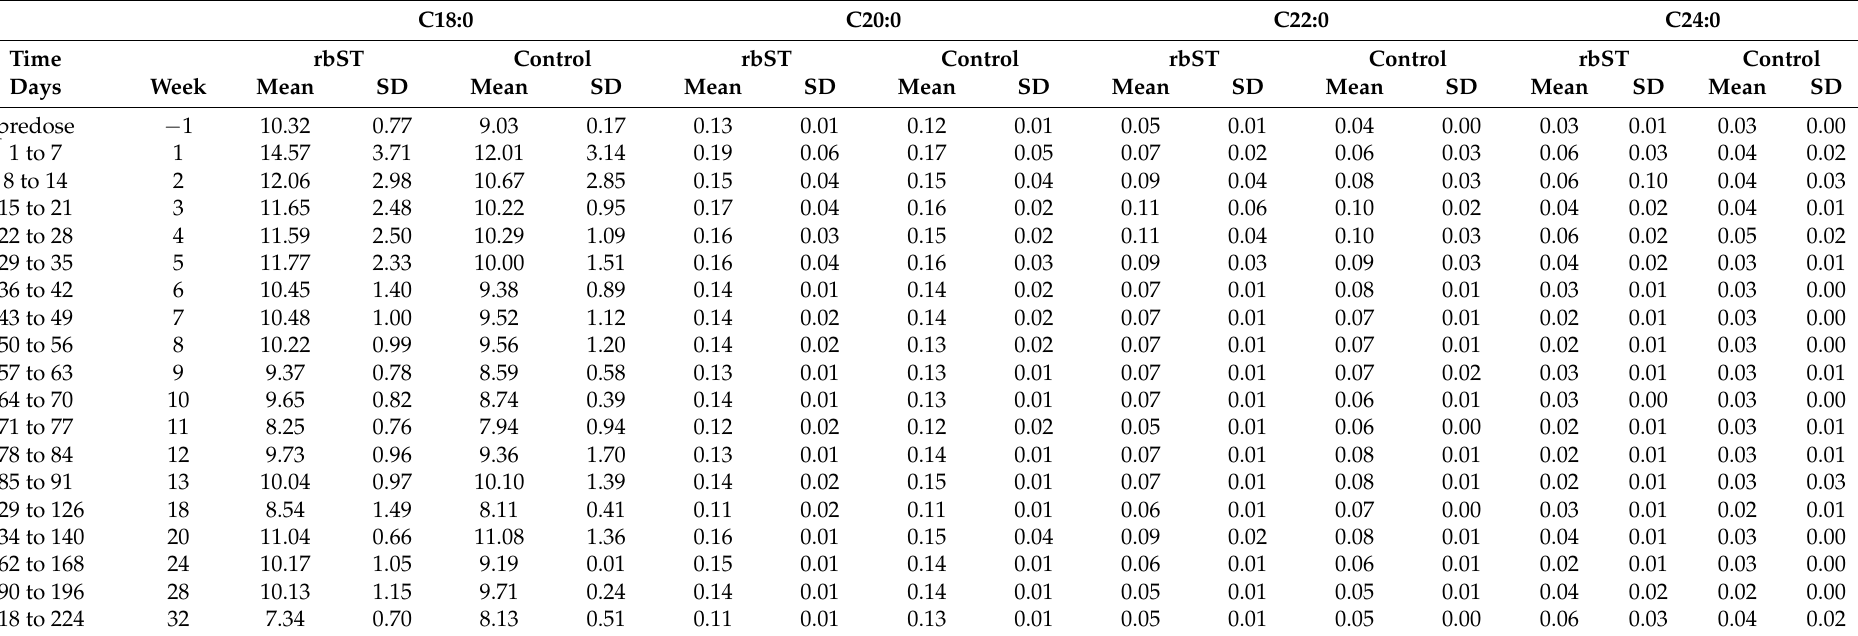
Table 3. Long-chain C18:0 and very-long chain ( ≥ 22) saturated fatty acids in milk (% w / w of total fatty acids) obtained from cows treated with recombinant bovine somatotropin (rbST) ( n = 6) and from control animals ( n = 3) at different time points selected over the course of 37 weeks (8 injections of Lactotropina manufactured by Elanco, Eli Lilly,